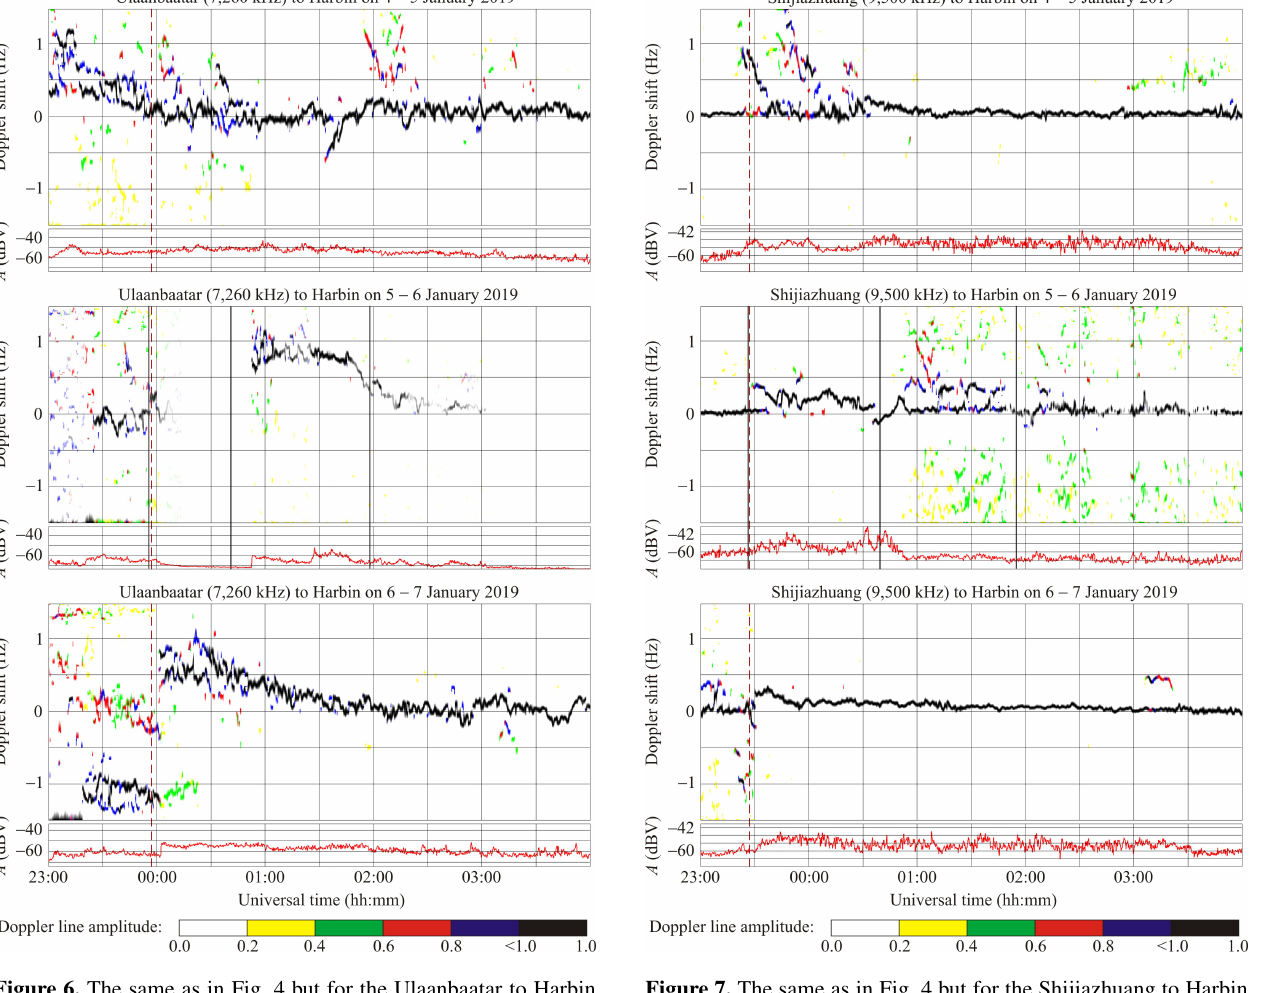
Figure 6. The same as in Fig. 4 but for the Ulaanbaatar to Harbin radio-wave propagation path.